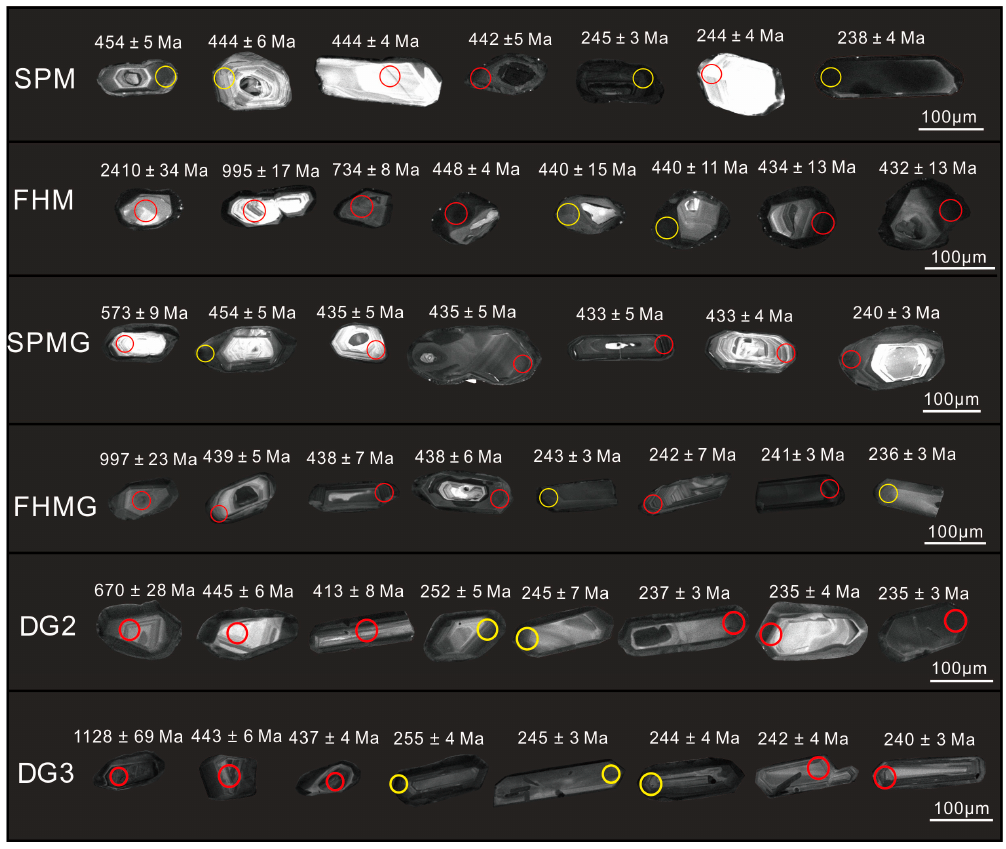
Figure 6. Representative cathodoluminescence (CL) images of analyzed zircons from metatexite samples (SPM, FHM), diatexite samples (SPMG, FHMG), and biotite monzogranite samples (DG2, DG3) samples in Fuhuling. Red circles show LA-ICPMS dating spots in inherited zircon of discordance values <10%, metamorphic zircon and magmatic zircon of discordance values <5%, and corresponding U-Pb ages. Yellow circles show LA-ICPMS dating spots in metamorphic zircon and magmatic zircon of discordance values >5%.